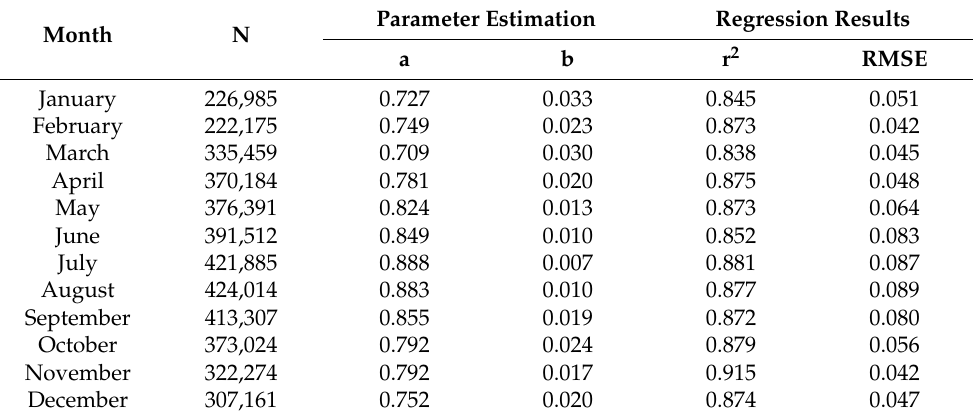
Table 2. The correlation between the GIMMS NDVI and the MODIS NDVI. Parameter Estimation Regression Results Month N a b r